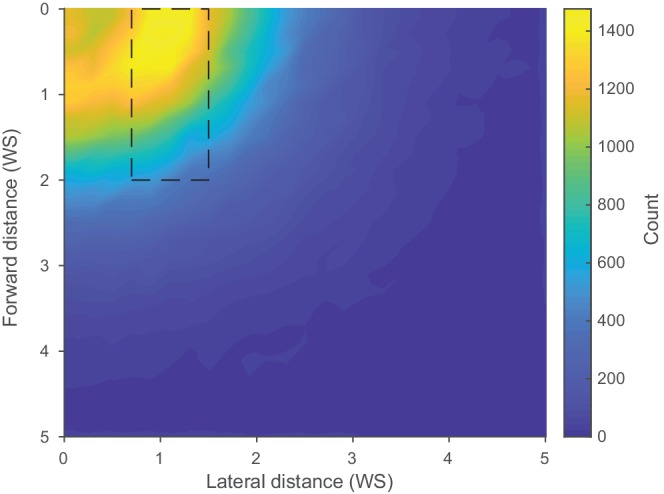
Distribution of nearest neighbors in the horizontal slice (±1 wingspan elevation) from all shorebird flock data described here, regardless of species.The dashed line box shows the ‘aerodynamic neighbor’ region for comparison with shorebird flocks, 29.3% of all nearest neighbors fall within this region. Data used for generating this figure are available in Figure 3—source data 1.